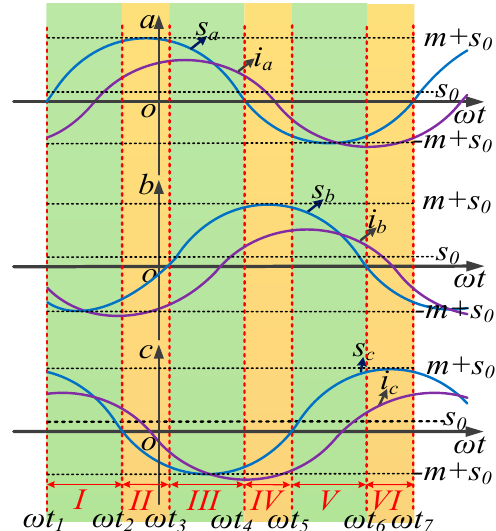
Figure 3. Distribution map of a complete primitive period.